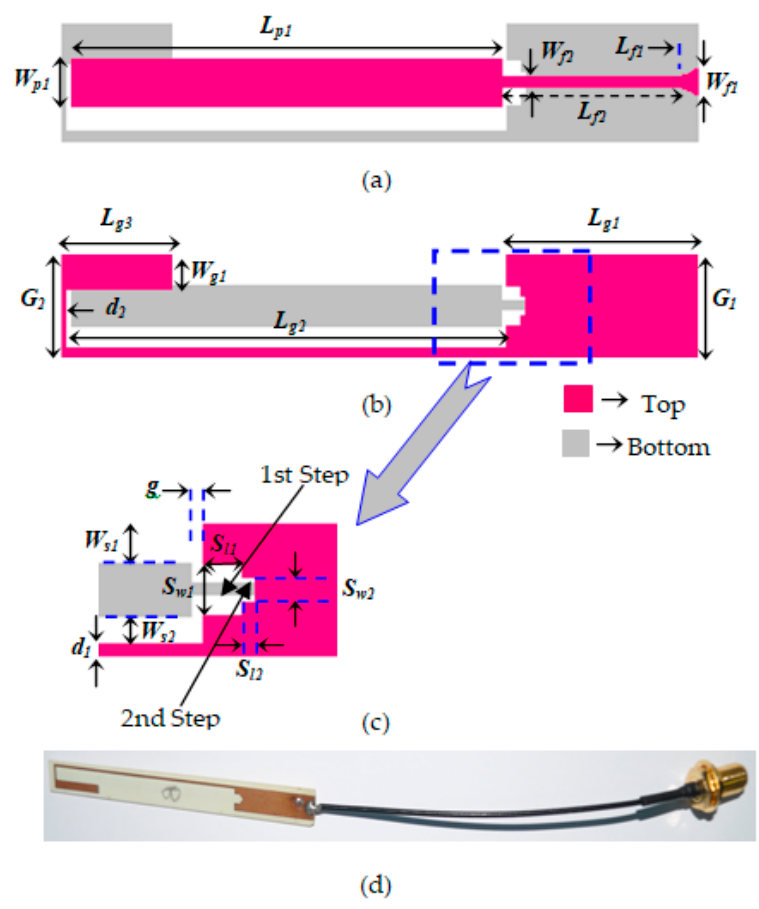
Figure 1. Layout of the proposed wideband antenna ( a ) front view, ( b ) back view, ( c ) steeped ground strip, and ( d ) prototype.